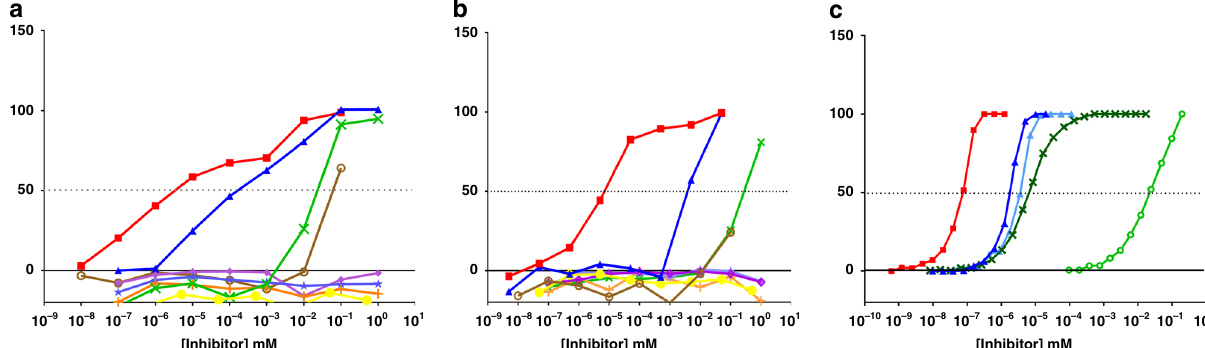
Fig. 4 Inhibition of the binding of anti-MenA antibodies to CPS. Competitive ELISA with anti-MenA mAb ( a ) and anti-MenA polyclonal serum ( b ) using different length nonacetylated carbaMenA oligomers as inhibitors and CPS as coating. c Competitive SPR of binding between anti-MenA mAb and immobilized biotylinated CPS. Inhibitors were reported as described: red curve for MenA CPS; blue curve MenA avDP – 15; light blue curve MenA DP8; brown curve MenA deOAc CPS; green curve carba DP8; dark green curve carbaDP8 OAc; purple curve carba DP4; light purple carba DP6; orange curve carba DP7; yellow curve negative control. MenA CPS and deOAc CPS were the positive controls and the β -glucan Laminarin was the negative control in a and b . MenA CPS and fragments thereof were used as positive controls and anti-MenC mAb was fl own on the chip as negative control in c . Data from a single experiment representative of two experiments is